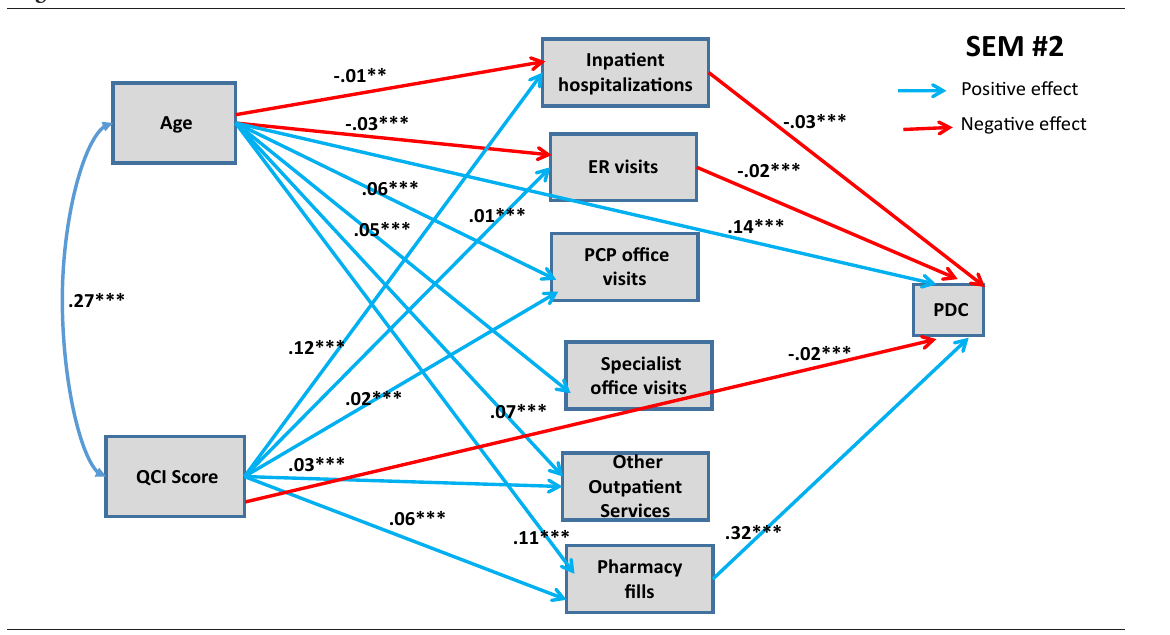
Figure 2. SEM #2 Presents Structural Determinants of PDC from HIRD Data